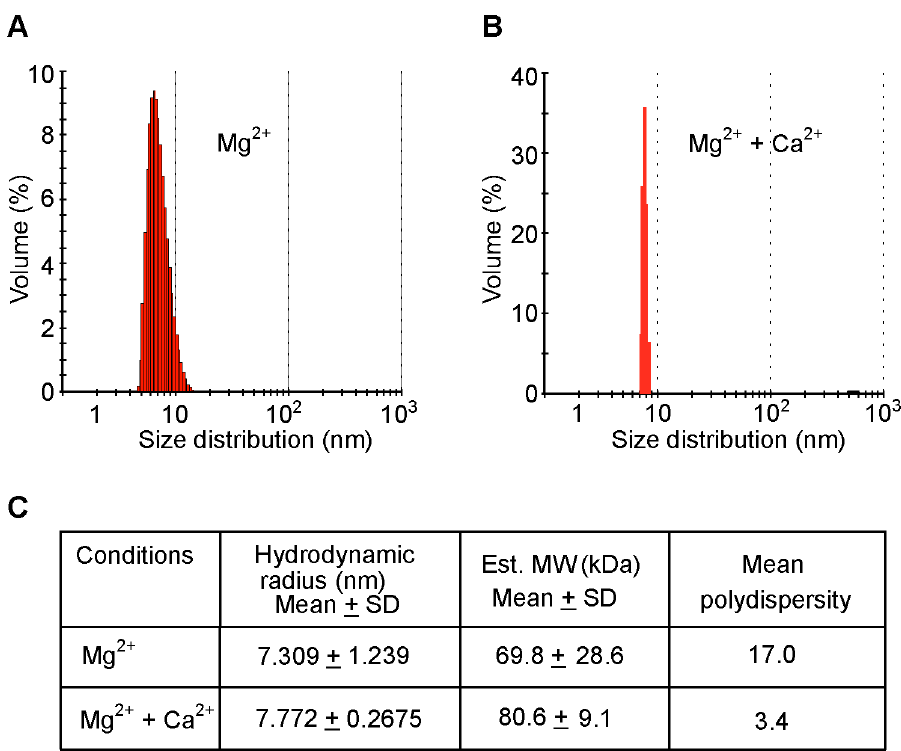
Figure 7. Dynamic light scattering (DLS) experiments further demonstrate the existence of a Caldendrin homodimer. (A) The radius of Caldendrin in the presence of Mg 2 + . Polydispersity suggests that Mg 2 + -bound Caldendrin may exhibit conformational heterogeneity or exist as an equilibrium mixture of monomer and dimer species. (B) DLS shows that Caldendrin in the Ca 2 + -bound state preferentially forms a dimer. (C) Table showing the molecular mass of Caldendrin, polydispersity in the presence of Mg 2 + (1 mM Mg 2 + / 1 mM EGTA) or Mg 2 + + Ca 2 + (1 mM Mg 2 + /50 m M Ca 2 + ). Experiments were repeated with three different purifications and from each puriifcation samples were measured six to seven times.